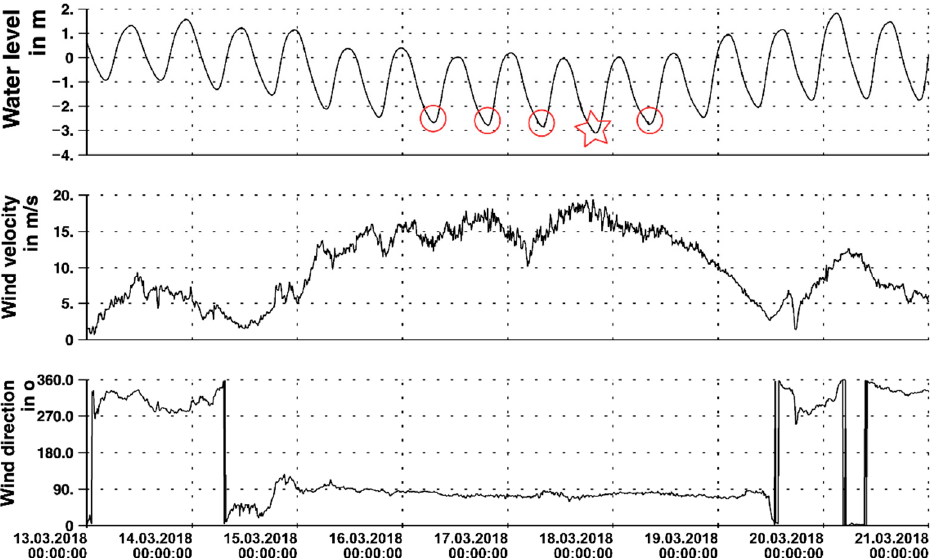
Figure 3. Observed water level relative to NHN at Cuxhaven and wind velocity and direction in 10 m height at Scharhörn between 13 March and 21 March 2018. The five consecutive LW levels, which can be categorized as ELWs according to our definition are marked by red circles, the lowest ELW of this period is marked by a red